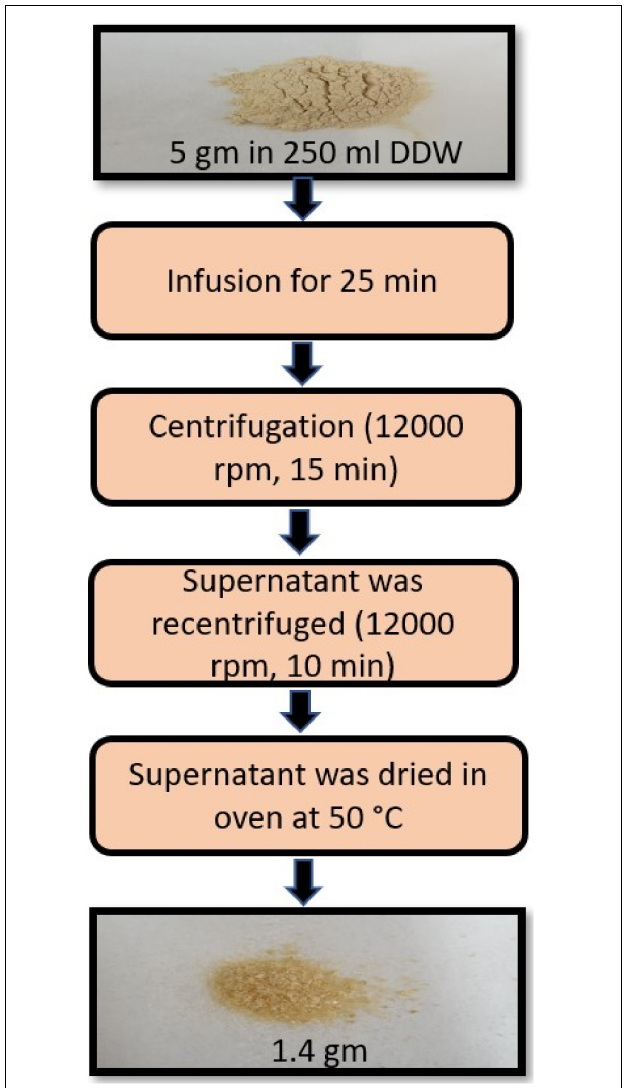
FIGURE 1 | Scheme for extraction of water-soluble material from the Withania somnifera root